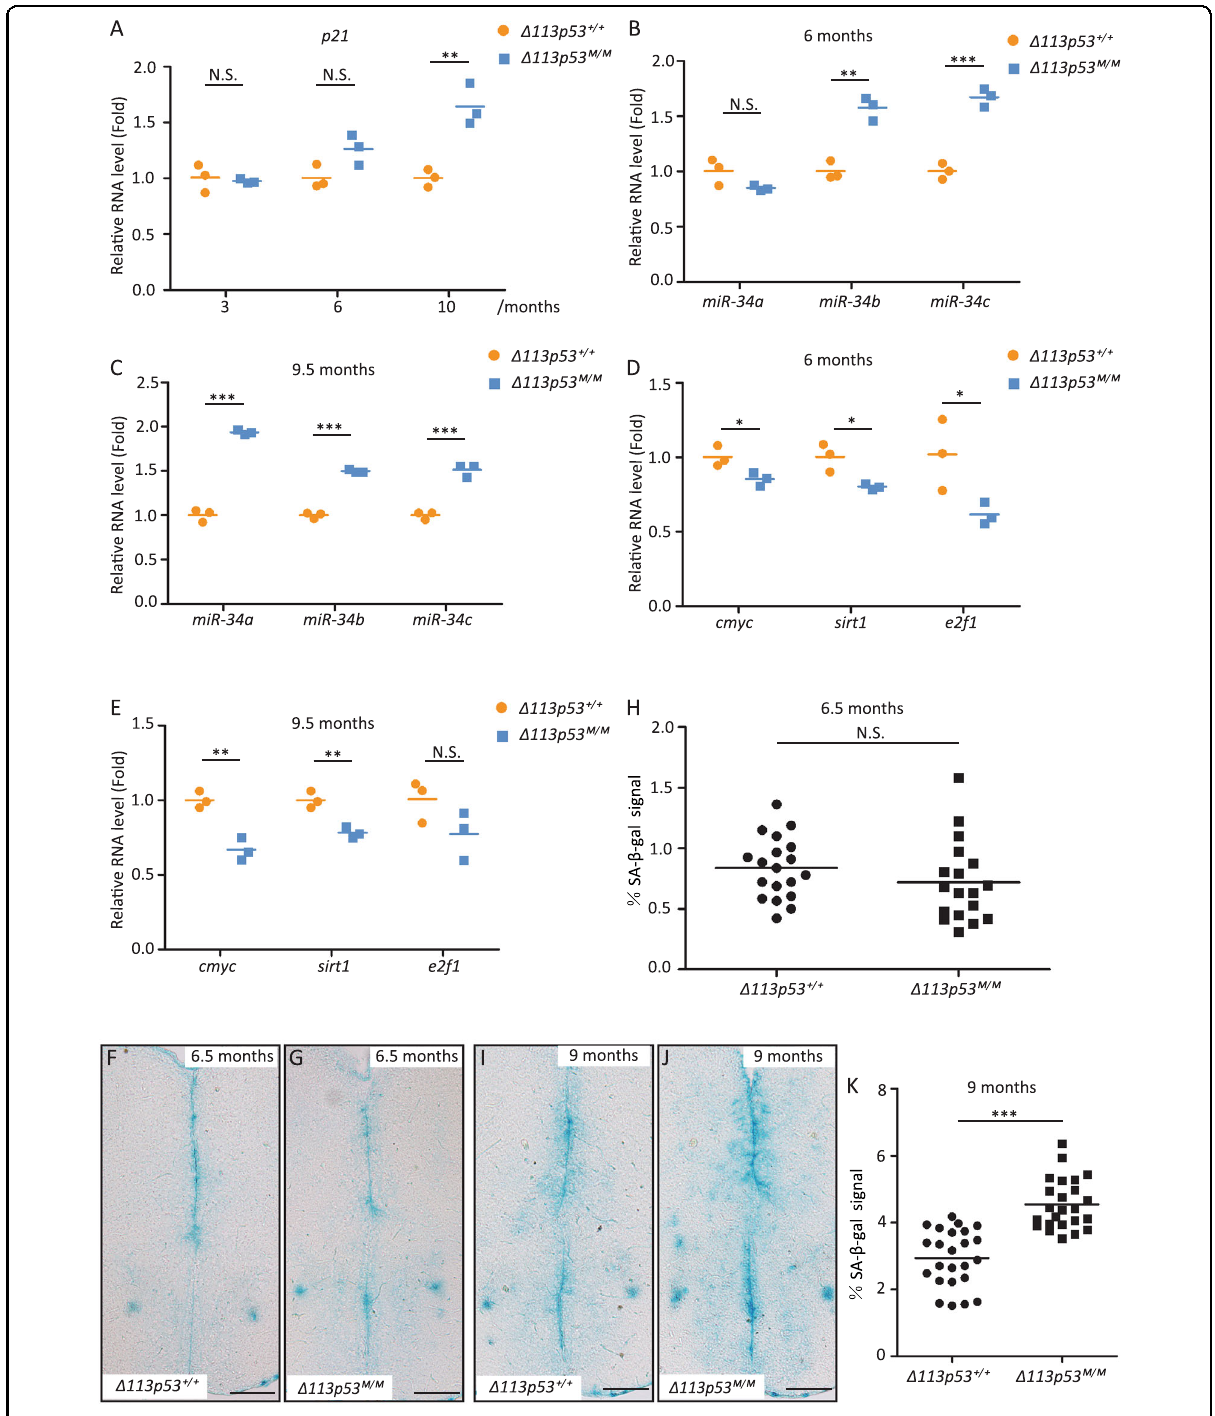
Fig. 5 Δ 113p53 M/M zebra fi sh telencephalon has increased levels of cell senescence markers. A – E Relative expression of p21 ( A ), cmyc , sirt1 , e2f1 mRNAs ( D , E ), and miR-34a , miR-34b , miR-34c miRNAs ( B , C ) at different ages in the Δ 113p53 + / + and Δ 113p53 M/M telencephalons, as indicated. The total RNA was extracted from a pool of at least six telencephalons in each group. The average gene expression of mRNAs and miRNAs was normalized against β -actin and U6 , respectively. F – K Senescence-associated β -galactosidase (SA- β -gal) staining in the telencephalons of Δ 113p53 + / + ( F , I ) and Δ 113p53 M/M zebra fi sh ( G , J ) at 6.5- and 9-months old as indicated. Scale bar, 100 μ m. The average SA- β -gal signal was quanti fi ed with Photoshop and presented as the percentage of pixels per unit area of the section measured in the telencephalon ( H , K ). Each dot represents the average SA- β -gal signal in each section. About three to fi ve sections were taken from the middle region of each telencephalon, and at least four telencephalons were sampled in each group. Statistical analysis was performed on relevant data using the Student ’ s two-tailed t test. N.S., P >0.05, * P < 0.05, ** P < 0.01, *** P < 0.001.